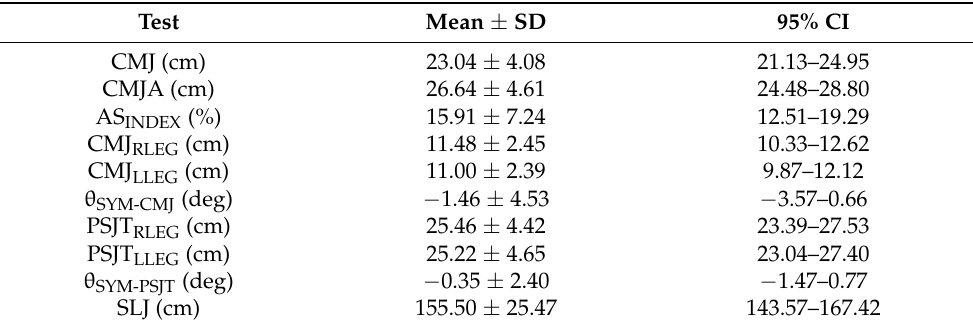
Table 6. Descriptive statistics for all tests and indexes examined in the present study for EGB (females, n = 20).